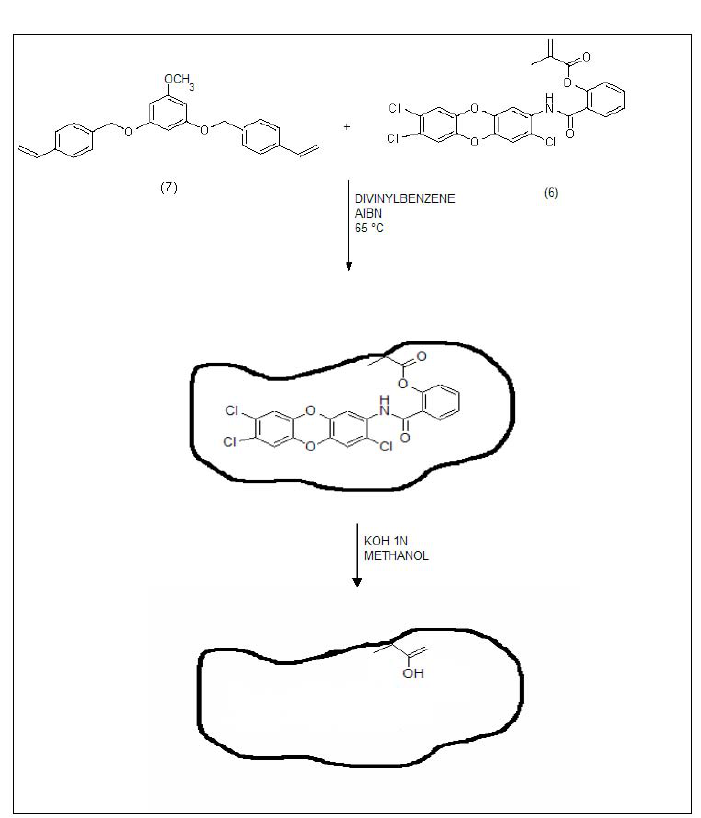
Figure 4. Synthesis of MIP1 and template